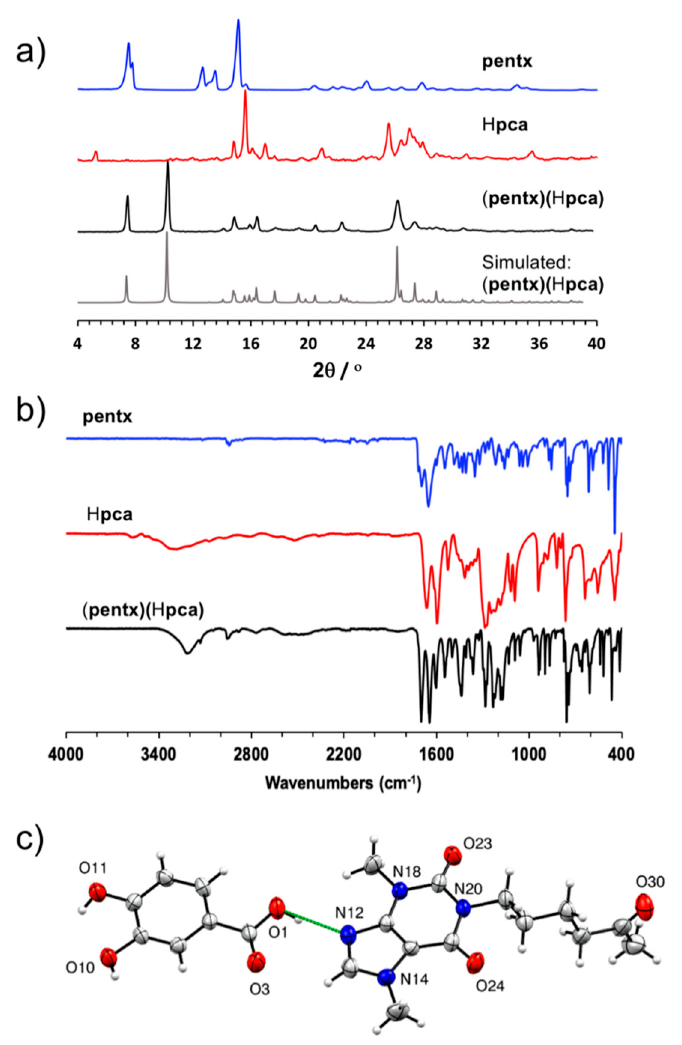
Figure 2. ( a ) Comparison of powder X-ray diffraction (PXRD) patterns, as well as ( b ) FTIR spectra for pentx , H pca , and the ( pentx )(H pca) co-crystal ( c ) The asymmetric unit in ( pentx )(H pca) , in which the ( pentx )(H pca ) entities are held together through hydrogen bond depicted in dashed green line.